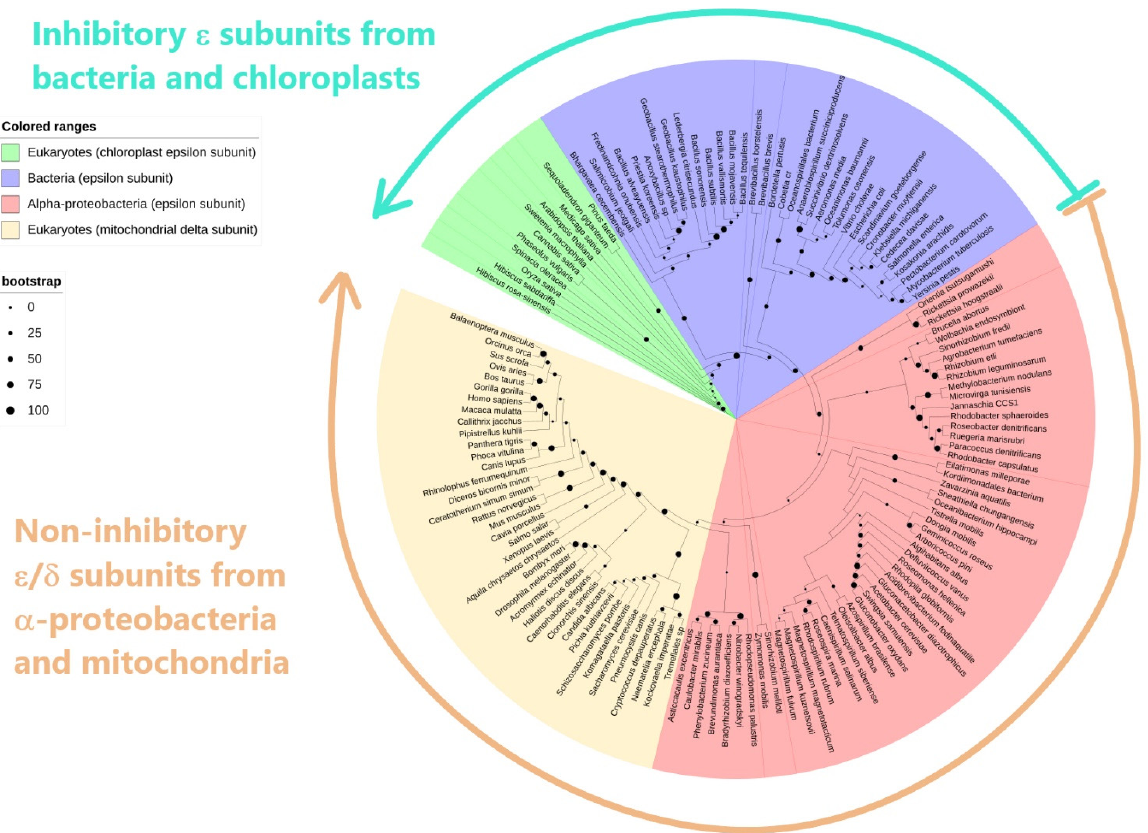
Figure 3. Cladogram of the ε subunit of the α -proteobacterial F-ATP synthase. A total of 137 protein sequences of ε subunits from α -proteobacteria (red), other bacteria (blue), chloroplast ε subunit (green), and homologous mitochondrial δ subunits (yellow) were aligned, and a maximum likelihood phylogenetic tree was constructed as detailed in the text. Green arrow: inhibitory ε subunits of bacteria and chloroplasts. Orange arrow: non-inhibitory ε and δ subunits of α -proteobacteria and mitochondria, respectively.